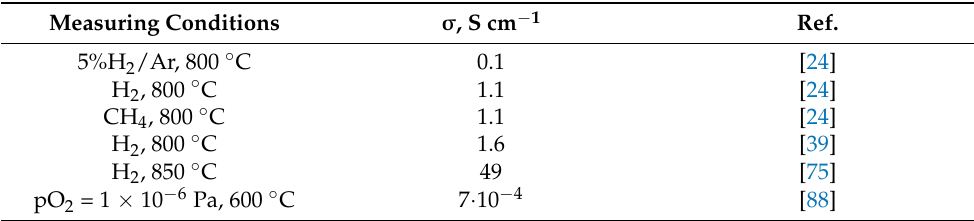
Table 3. Conductivity of Sr 2 NiMoO 6- δ . These data are also presented in Figure A2. Measuring